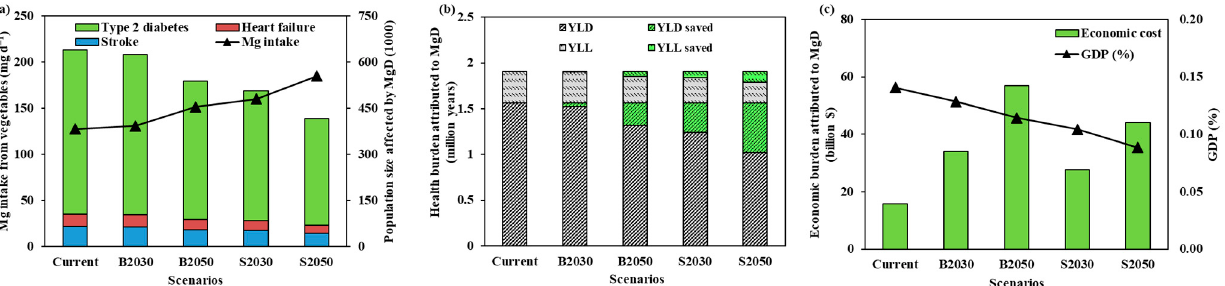
Figure 4. The scenarios analysis of Mg intake from vegetables (Formula (4)), number of cases attributed to Mg deficiency ( a ), DALYs lost, DALYs saved ( b ) (Formula (5)), economic burden attributed to Mg deficiency and its percentage to GDP ( c ). B2030 and B2050 represent business as usual vegetable productions in 2030 and 2050 (based on ( a )), and S2030 and S2050 represent improving vegetable Mg contents by 22% through biofortification (based on ( b )).